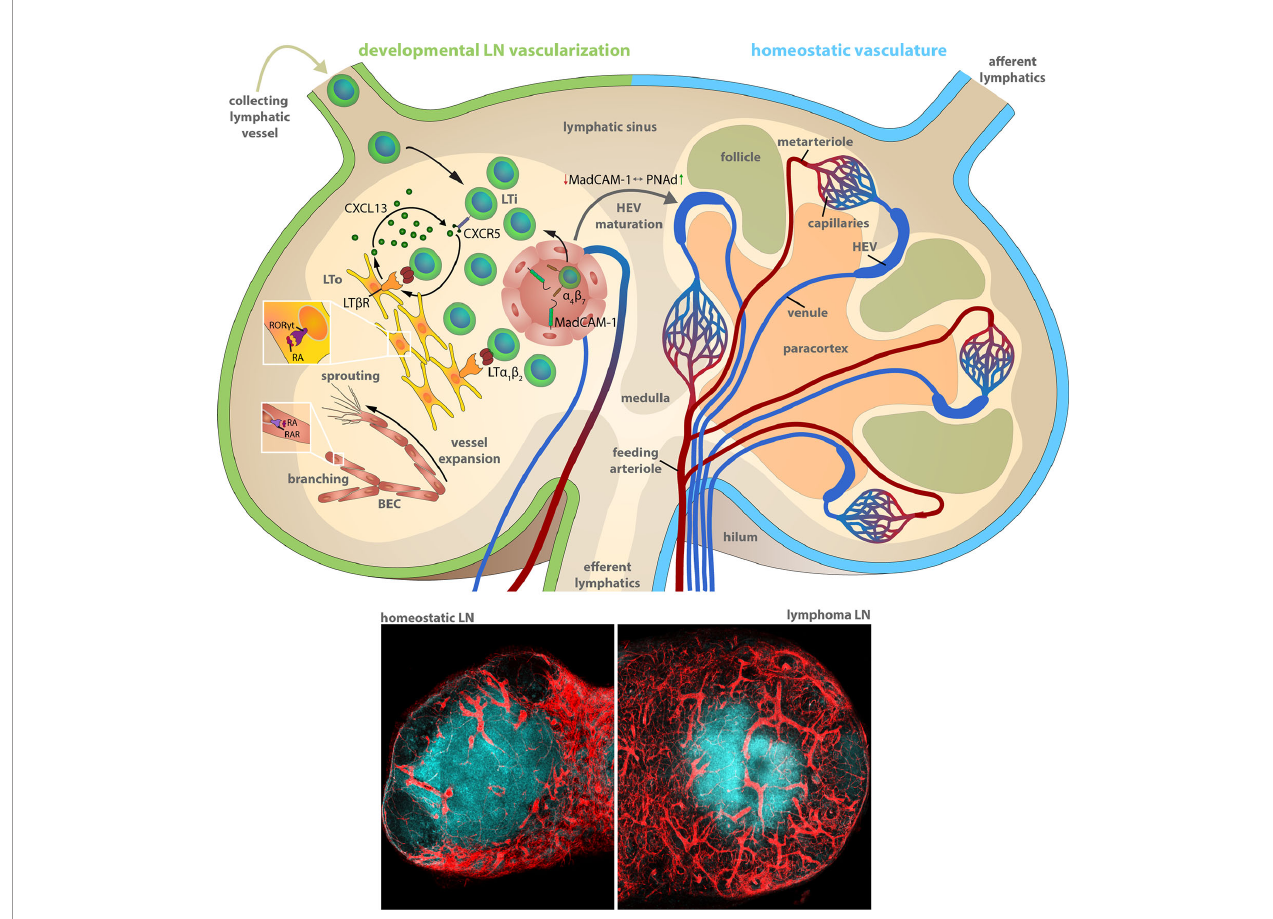
lymphotoxin (LT) a 1 b 2 - LT b receptor signaling, which secrete LTi-recruiting CXCL13 in turn. LTi recruitment from the blood circulation and the afferent lymphatics accumulates LTi cells within the LN anlagen resulting in a self-amplifying process of LN development. a 4 b 7 integrin-expressing LTi recruitment and extravasation